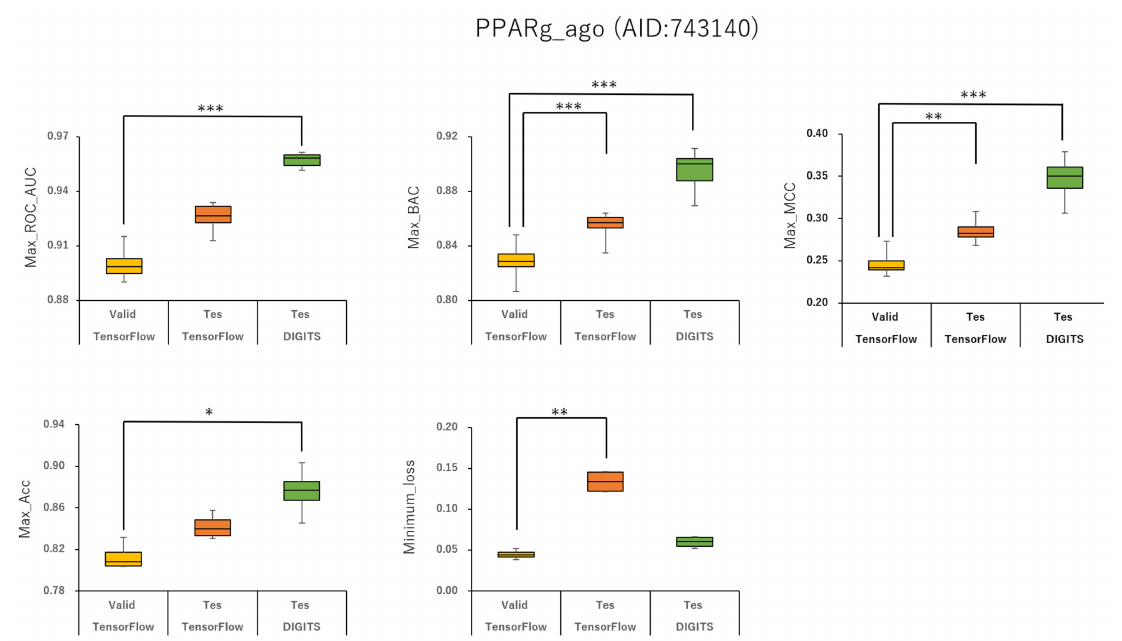
Figure 6. Max ROC_AUC, max BAC, max MCC, max Acc, and minimum loss of PPARg_ago (AID:743140) in validation and test datasets in TensorFlow and test dataset in DIGITS. * p < 0.05, ** p < 0.01, *** p < 0.001 for t